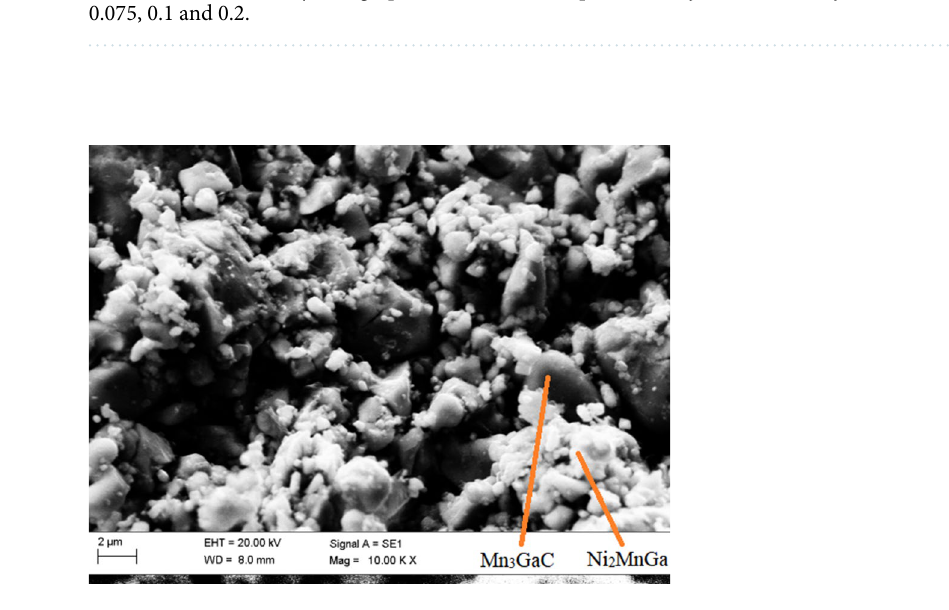
Figure 2. SEM micrograph showing the two phases in 0.75 [Mn 3 GaC] + 0.25 [Ni 2